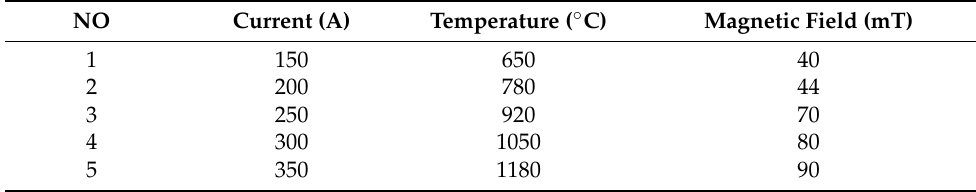
Figure 2. Schematic diagram of magnetic-anisotropic spark plasma sintering (MASPS). Table 1. Magnetic field (mT) to current (A) relation.